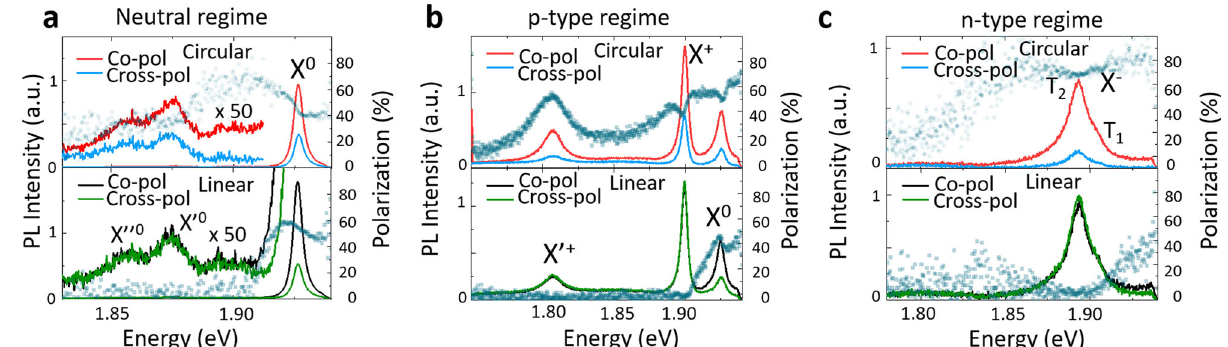
Fig. 3 Polarization behaviour of the photoluminescence. Polarization-resolved photoluminescence (PL) emission under circularly polarized excitation and linearly polarized excitation for different gate voltages, + 3V ( a ), + 30 V ( b ) and − 20 V ( c ). Here the PL components co-polarized and cross-polarized with respect to the laser are denoted by co-pol and cross-pol, respectively. Also shown is the energy-resolved degree of PL polarization (blue